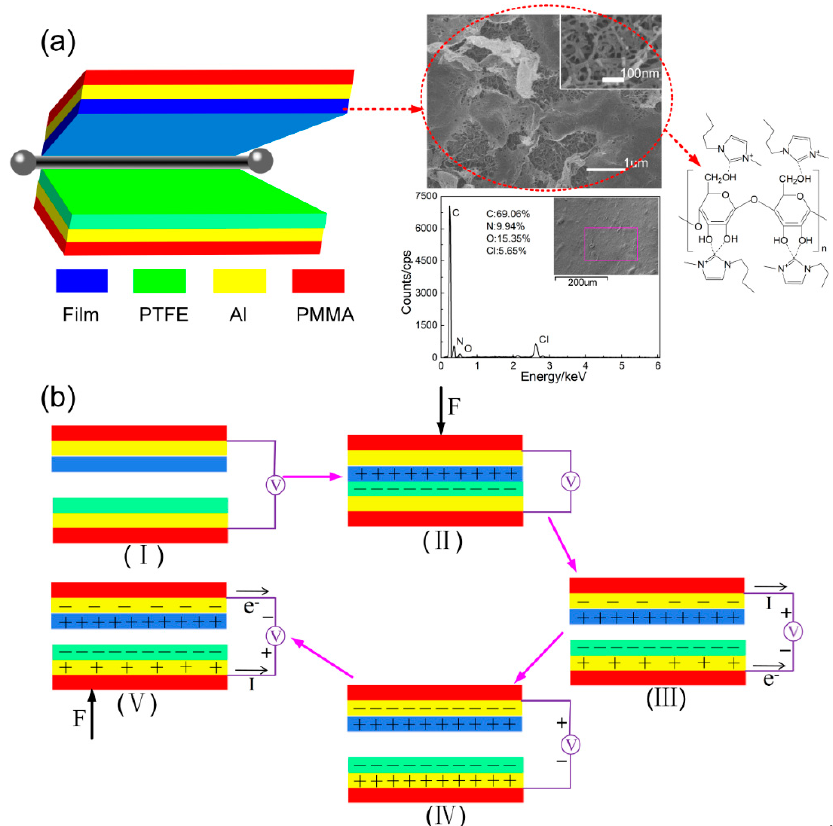
Figure 1. ( a ) Schematic diagram of cellulose composited nano-generator, ( b ) working principle diagram of cellulose composited